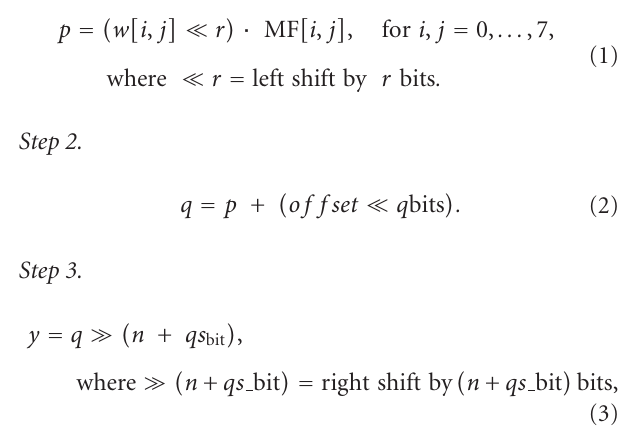
Table 1: Description of di ff erent parameters of the proposed